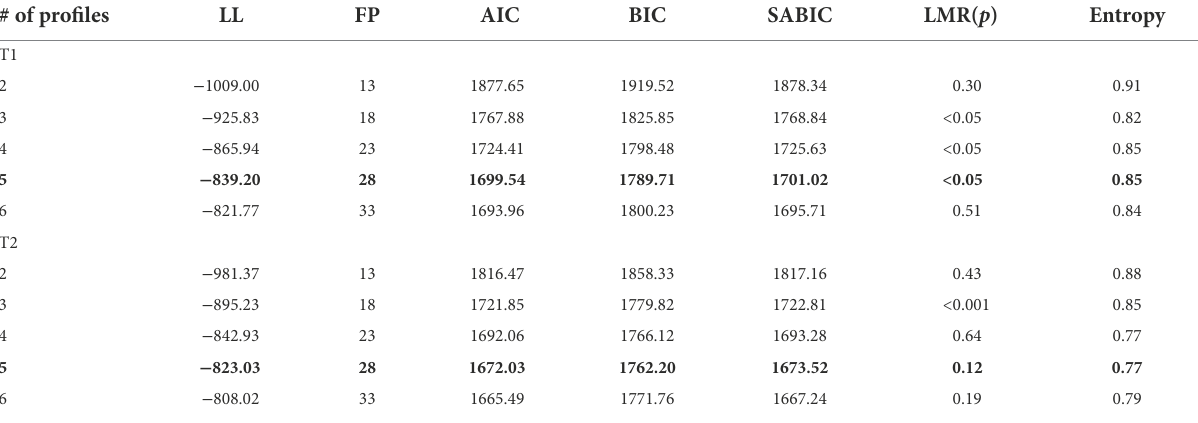
TABLE 2 Fit indices and number of profiles for T1 and